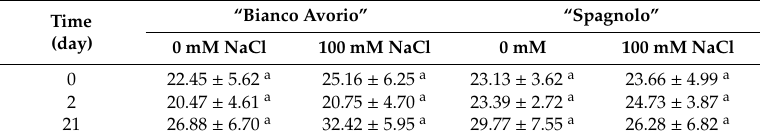
Table 2. Chlorophyll content (SPAD value) of the two cultivated C. cardunculus var altilis genotypes “Bianco Avorio” and “Spagnolo” after 0, 2, and 21 days of 0 (control) and 100 mM (salinity treatment) NaCl.